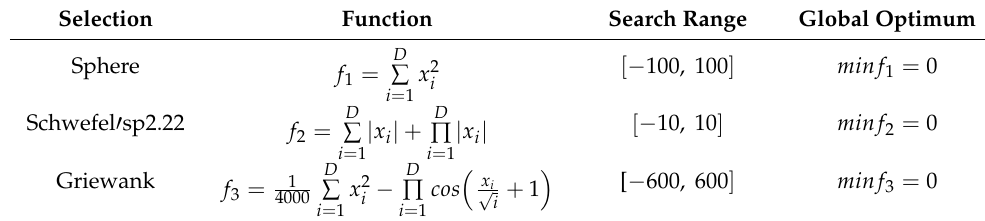
Table 1. Three test functions.